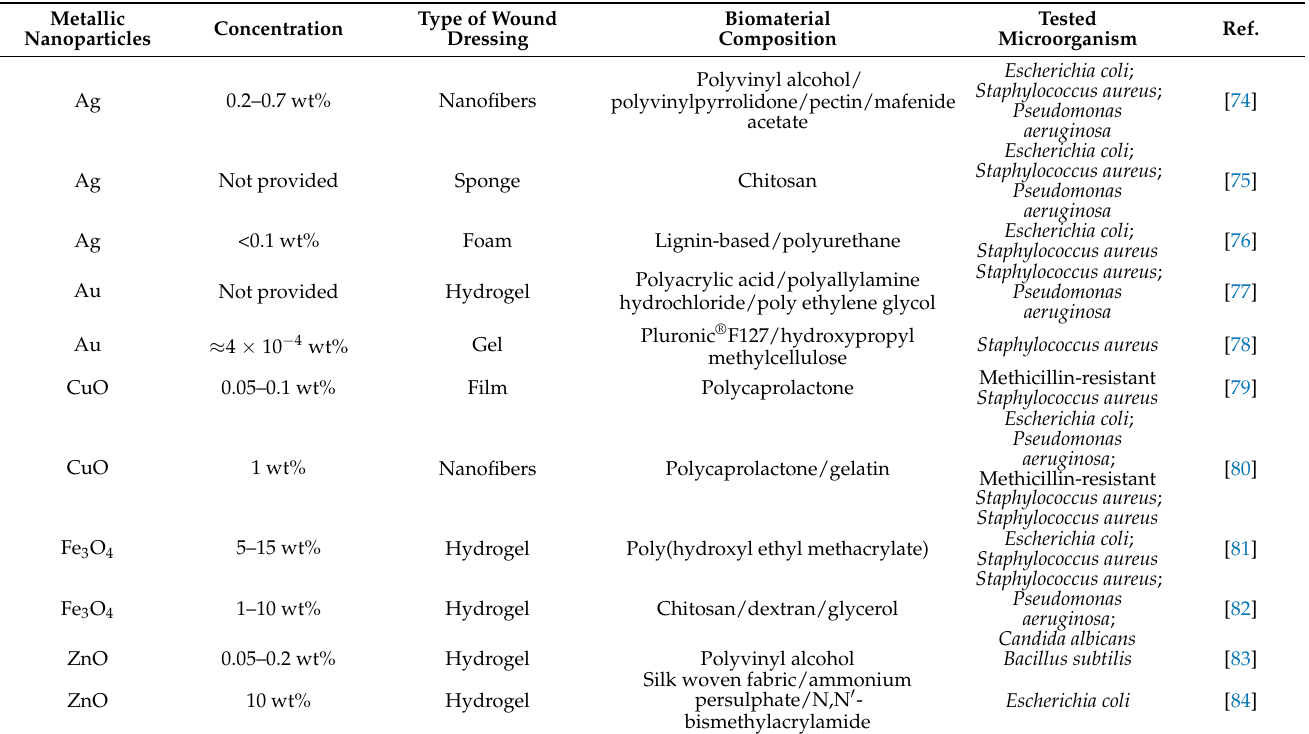
Table 3. Antimicrobial metallic-nanoparticle-loaded biomaterials for wound healing applications. Metallic Concentration Type of Wound Nanoparticles